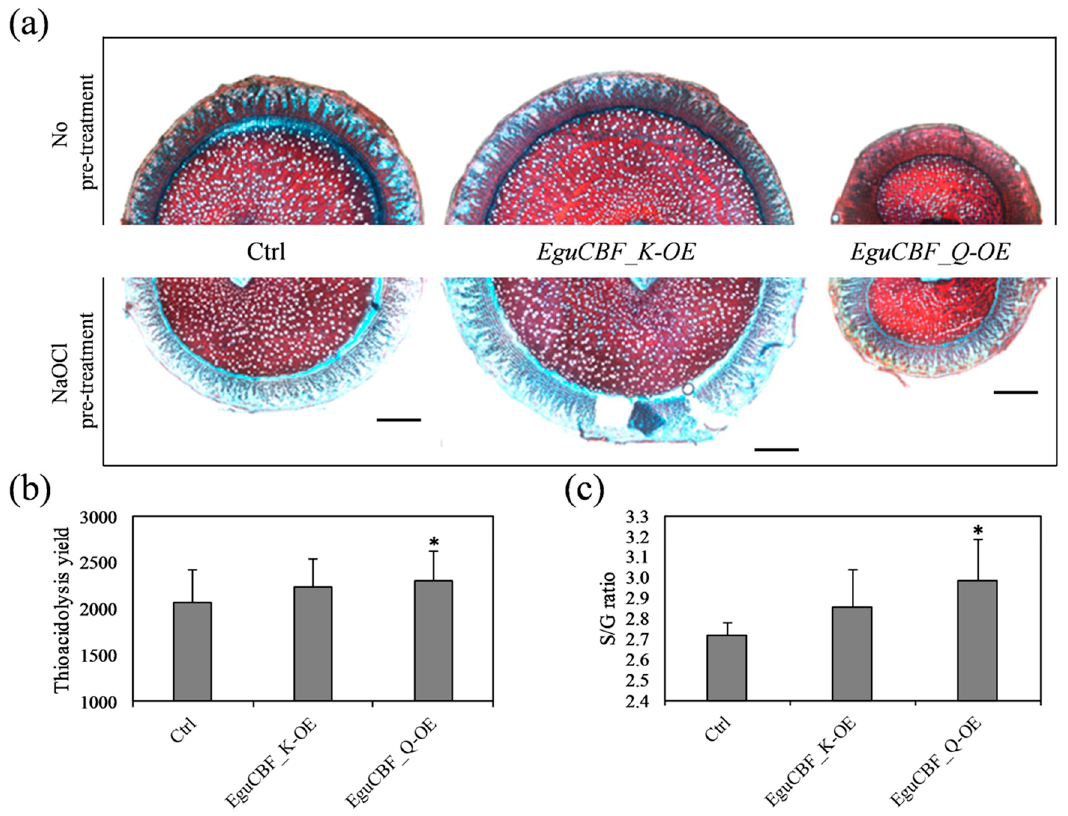
Figure 6. Impact of CBF overexpression on xylem biochemical composition. ( a ) Transversal stem sections stained with Safranin–Astra blue counterstaining before (top panel) and after (bottom panel) treatment with sodium hypochlorite (bleaching). ( b ) Total β -O-4 linked lignin and ( c ) lignin monomers ratio (S (syringyl) / G (Guaiacyl)) measured through thioacidolysis. Scale bar = 1 mm.